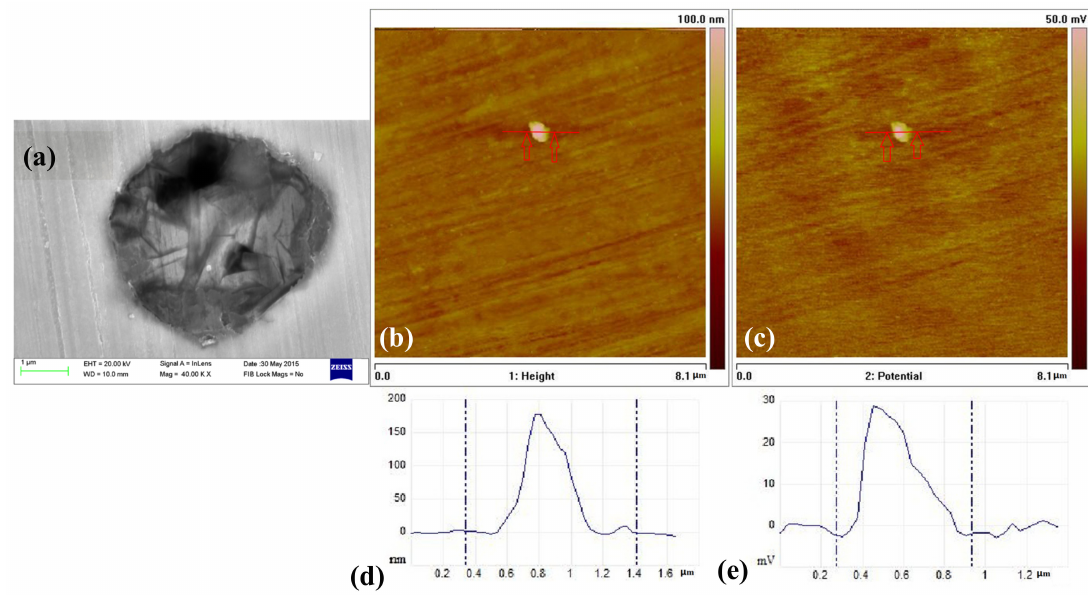
Figure 9. SEM and SKPFM images around the type B inclusion: ( a ) SEM image; ( b ) AFM topography image; ( c ) Surface potential distribution of the same area; ( d ) Topography section analysis; ( e ) Section analysis of the surface